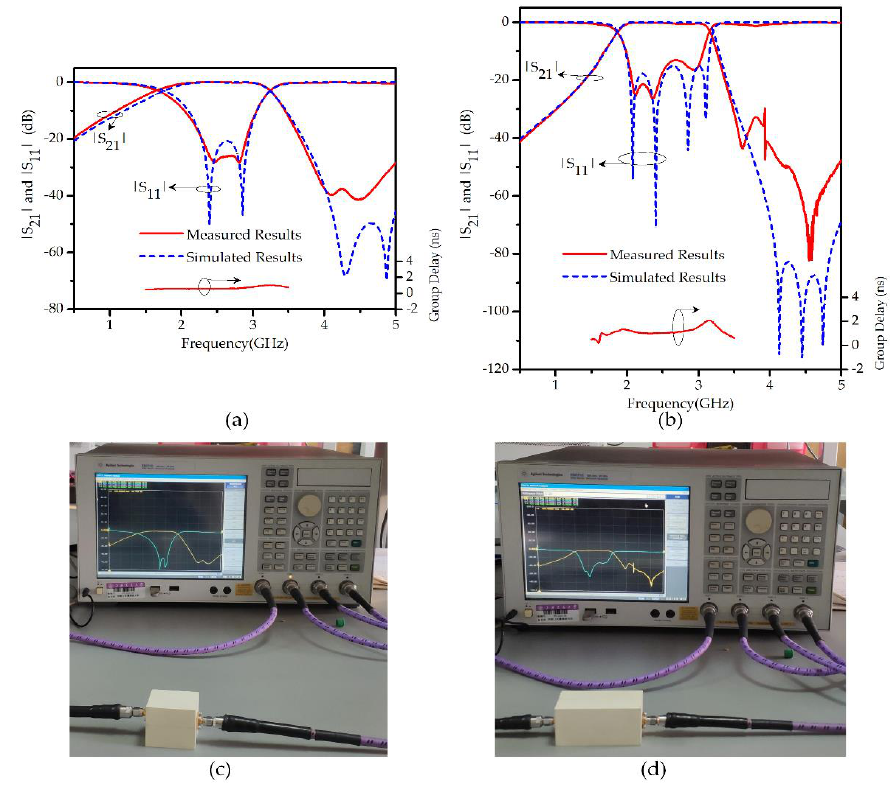
Figure 6. Installation and assembly of the two-cavity filter.